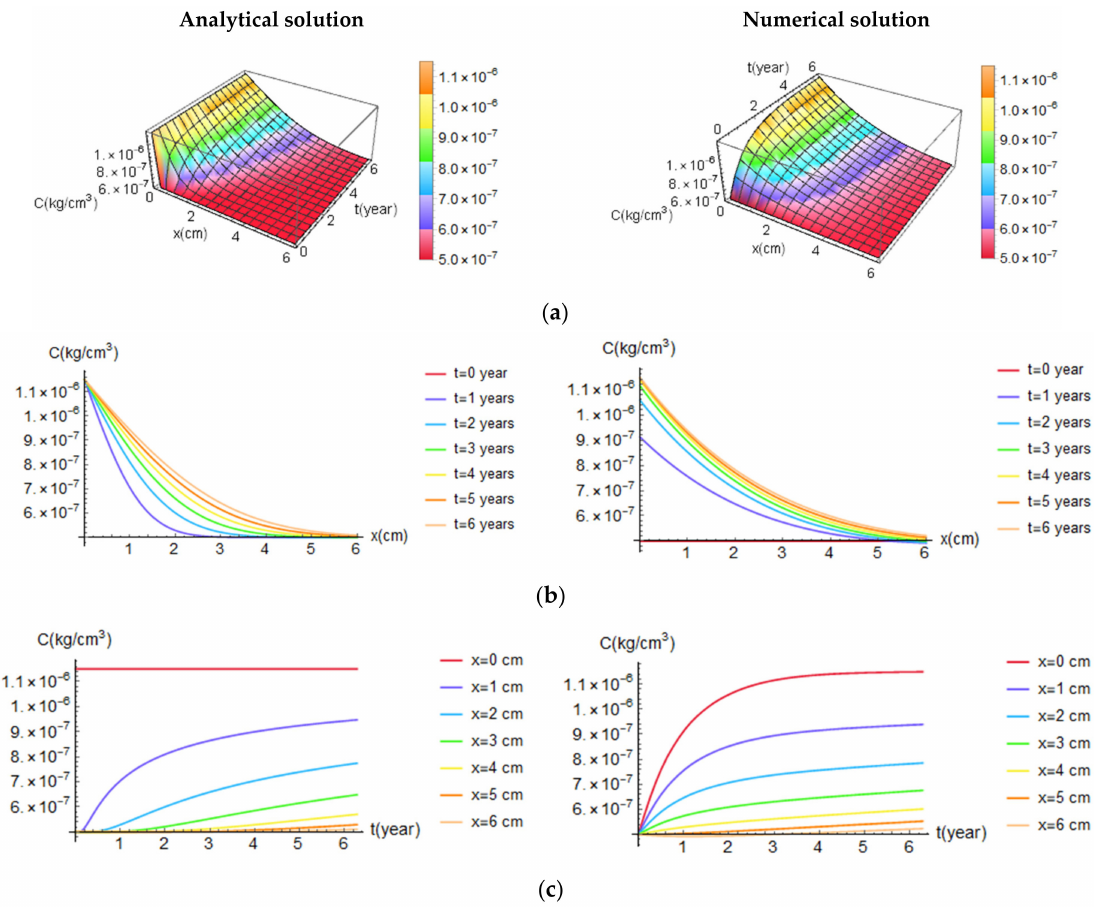
Figure 5. Results for constant f D (x,t): ( a ) 2D complete results; ( b ) results in x domain; ( c ) results in t